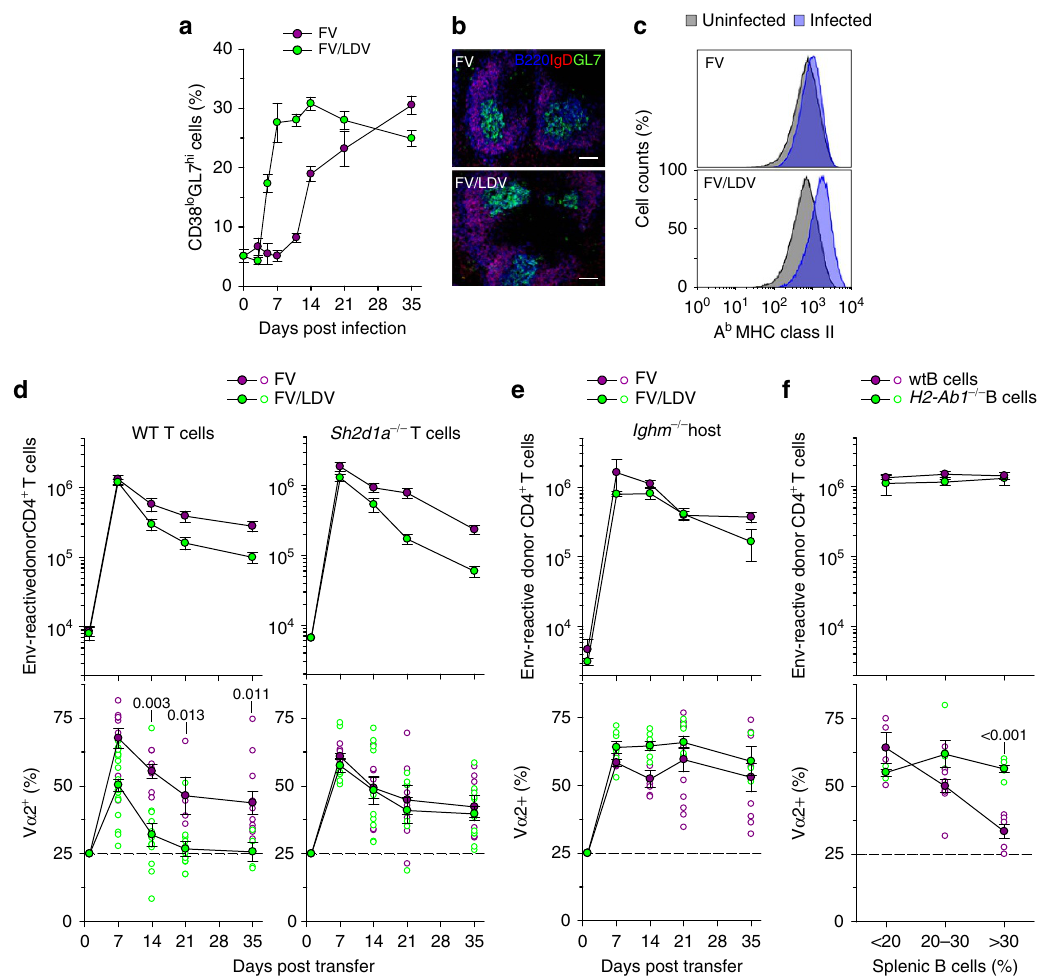
Figure 4 | Clonal replacement in virus-specific CD4 þ T cells requires cognate B-cell interaction. ( a ) Frequency of germinal center-phenotype (CD38 lo GL7 hi ) cells in CD19 þ IgD lo splenic B cells over the course of FV infection or FV/LDV coinfection ( n ¼ 4–13; P o 0.002 between the two